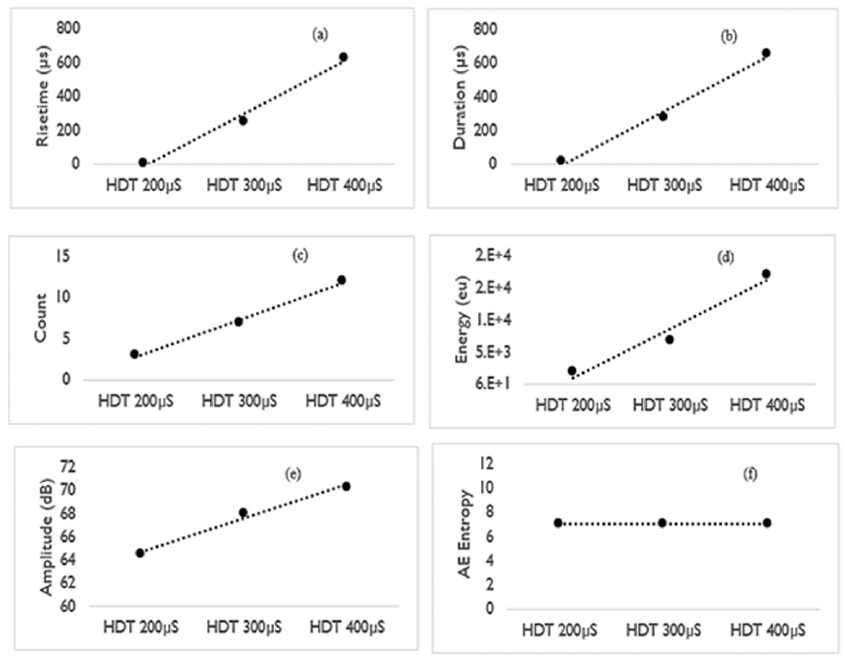
Figure 14. Influence of HDT on a realistic AE waveform. ( a ) Rise-time, ( b ) duration, ( c ) count, ( d ) energy, ( e ) peak amplitude, and ( f ) AE entropy.